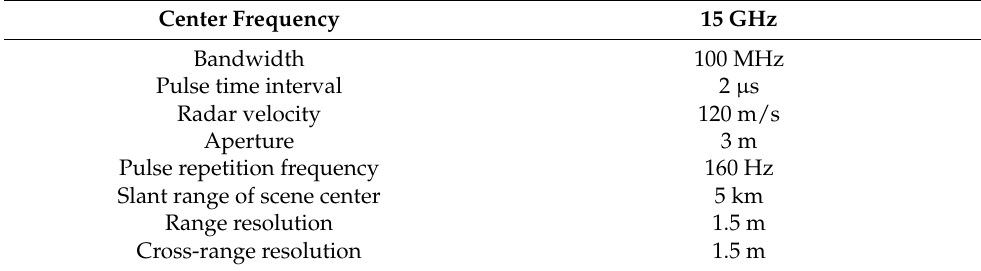
Table 5. Real SAR